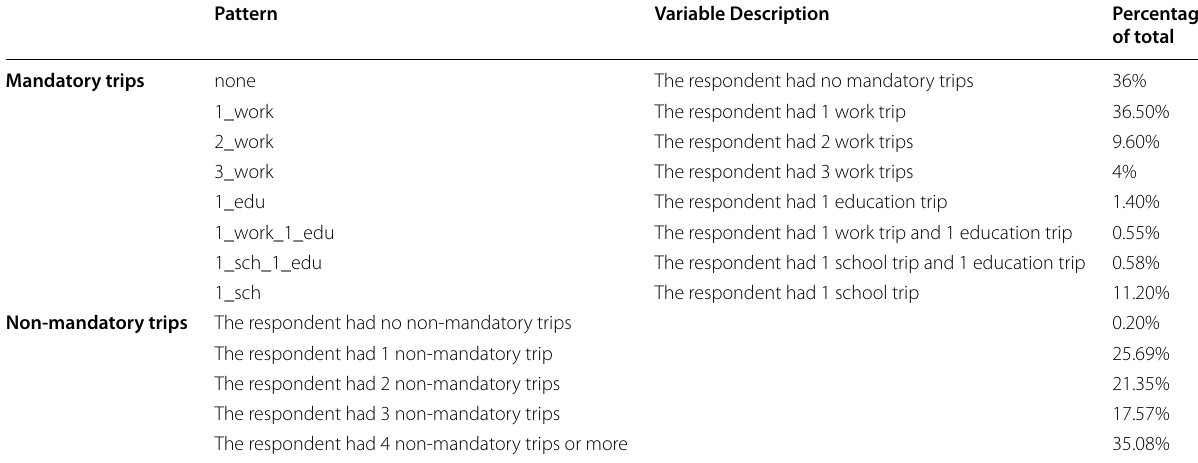
Table 3 Mandatory and non-mandatory trips Pattern Variable Description Percentage